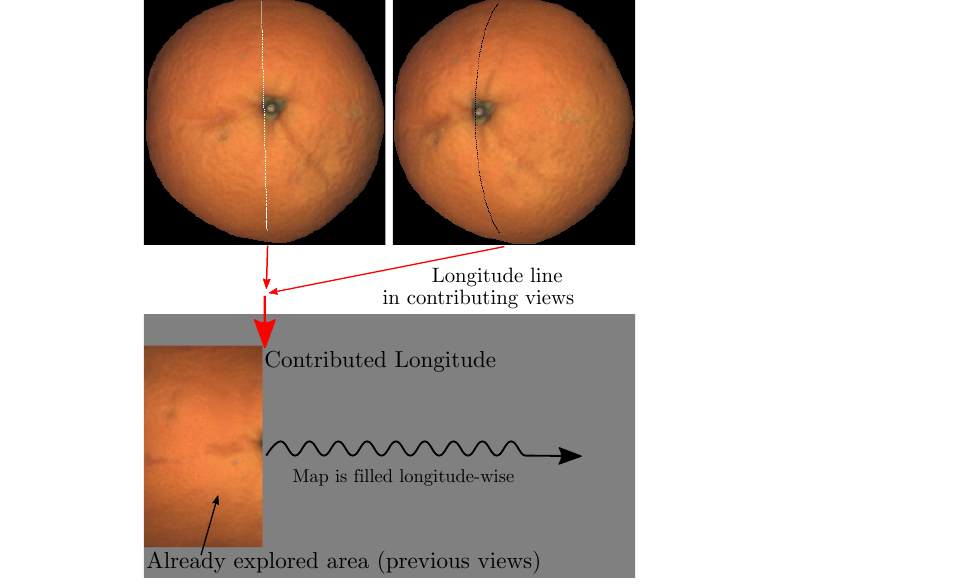
Figure 7. Pixels used to fill one meridian of the map. An animation of the process can be downloaded from